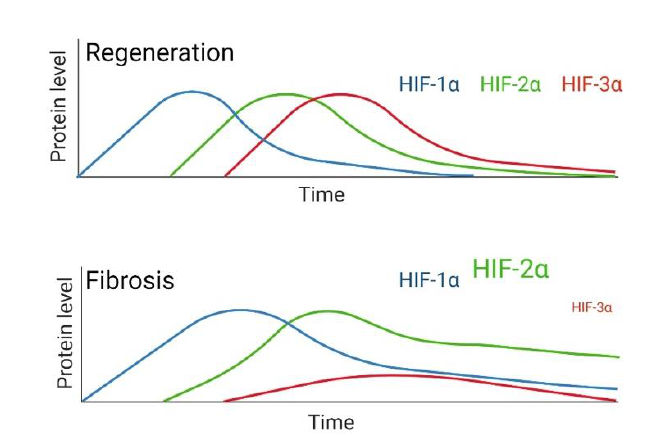
Figure 4. Hypothesized difference in the kinetic pattern of HIFs between a fibrotic and regenerative model during hypoxia.